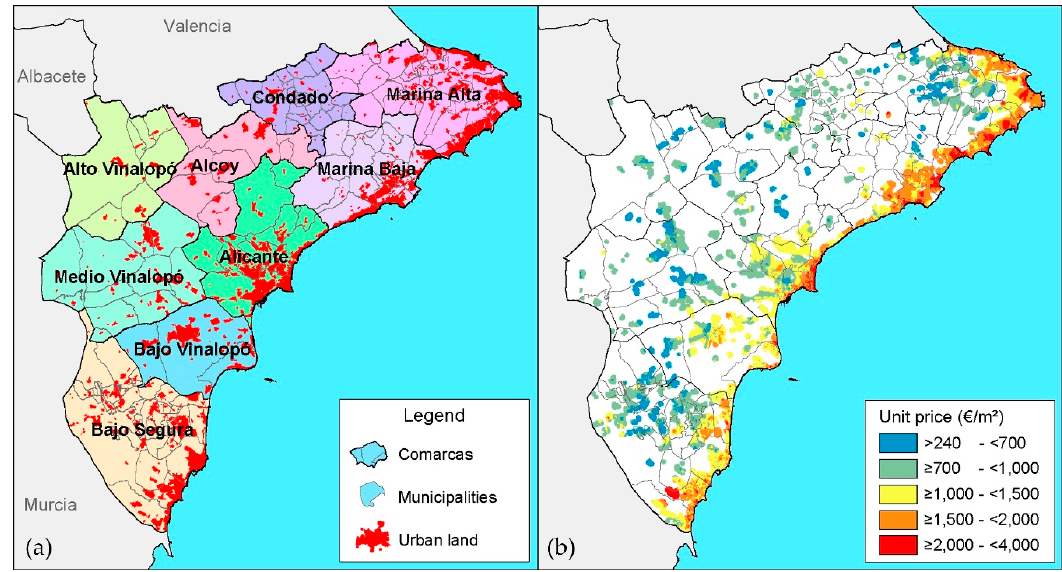
Figure 3. ( a ) Map of the province of Alicante with the delimitation of the comarcas , municipal boundary delimitation and the stain of continuous urban land; ( b ) kernel density map with unit prices of multi-family houses (euros/m 2 ).